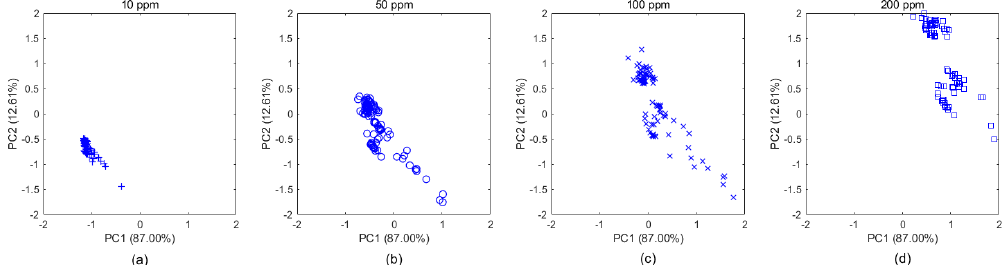
Figure 4. Example of the data drift caused by concentration in Batch 10. The Figure 4a–d show that the original data of ethylene samples (with 4 different concentrations) in Batch 10 is projected into two dimensional subspaces, whose basis is two principal components computed by PCA. The drift causes the distribution of ethylene data in the same batch to be different from the different concentrations.